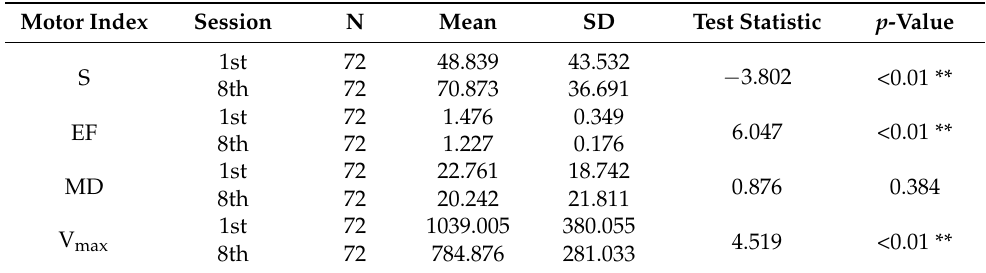
Table 6. Summary statistics and paired t -test for comparing motor indecies in Mode 2 between the first and eighth training for the Tracing task.